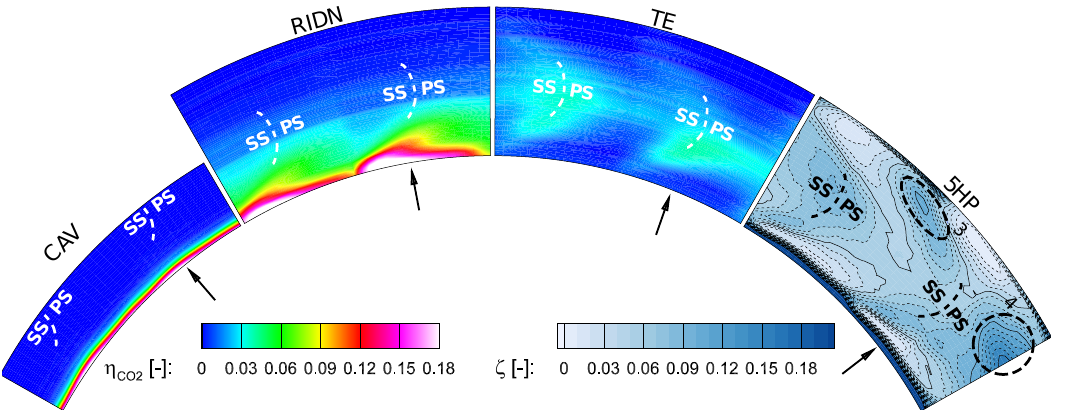
Figure 13. NGV exit plane, SWP, MFR 3, CAV-/RIDN-/TE-seeding and loss contours from 5HP measurements. Arrows indicate the swirler core position projected in the flow